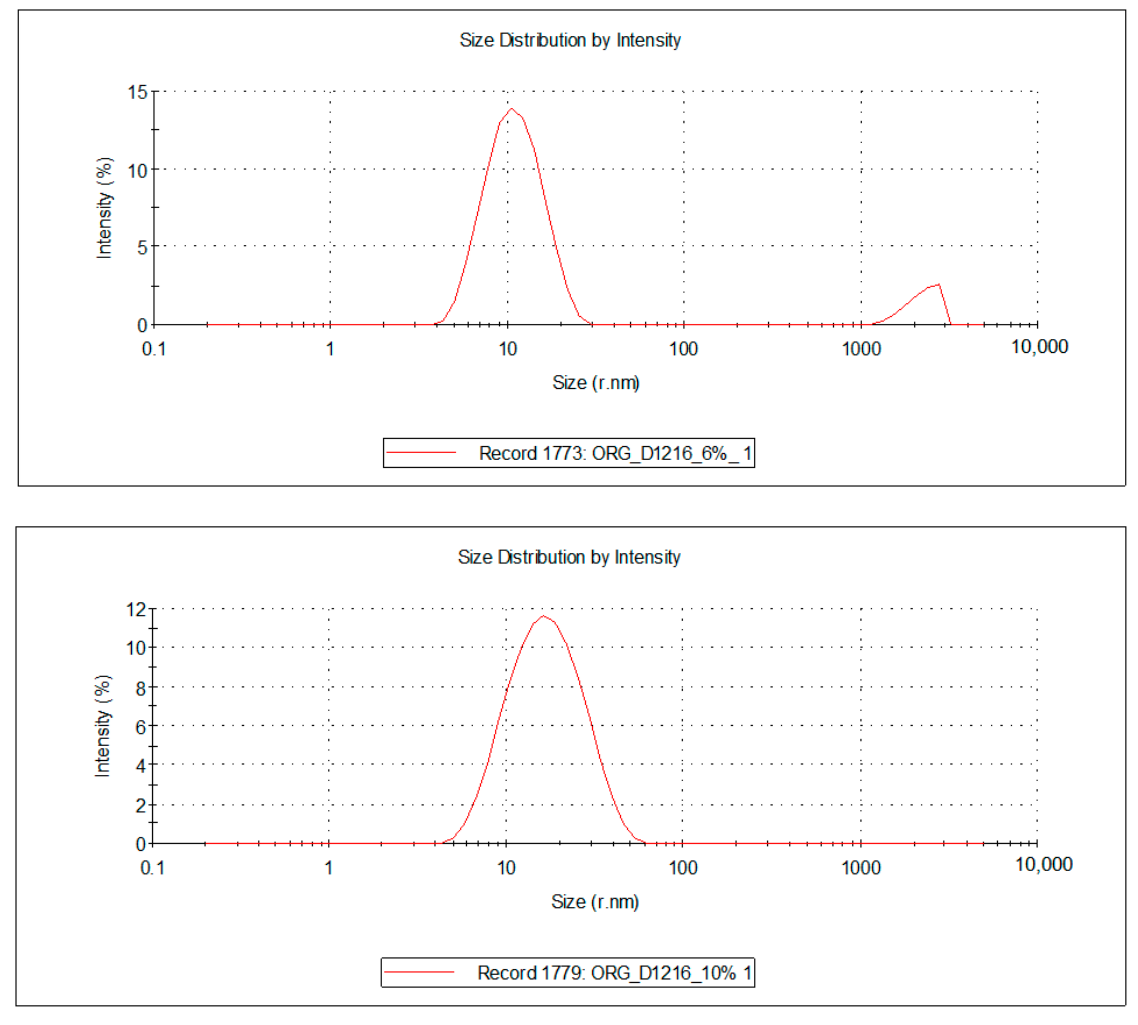
Figure 5. Droplet size distribution of the FZ-loaded microemulsions based on oregano essential oil and sucrose ester (sucrose palmitate or laurate).